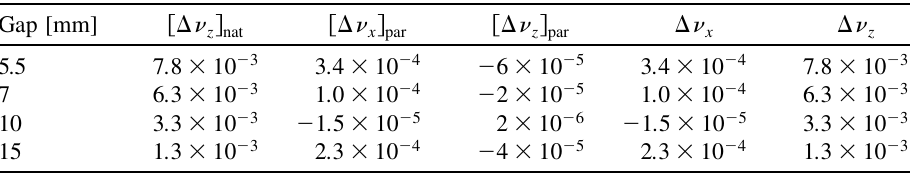
TABLE IX. Calculated vertical and horizontal tune shifts ½ (cid:2) (cid:7) z (cid:2) nat , ½ (cid:2) (cid:7) x (cid:2) par , ½ (cid:2) (cid:7) z (cid:2) par , (cid:2) (cid:7) x , and (cid:2) (cid:7) z induced by the wiggler versus the gap. Gap